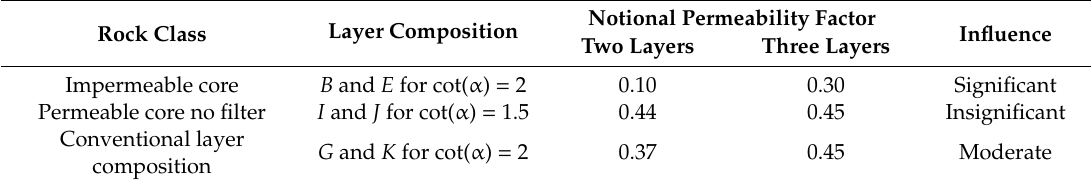
Table 4. Influence of armor layer thickness.